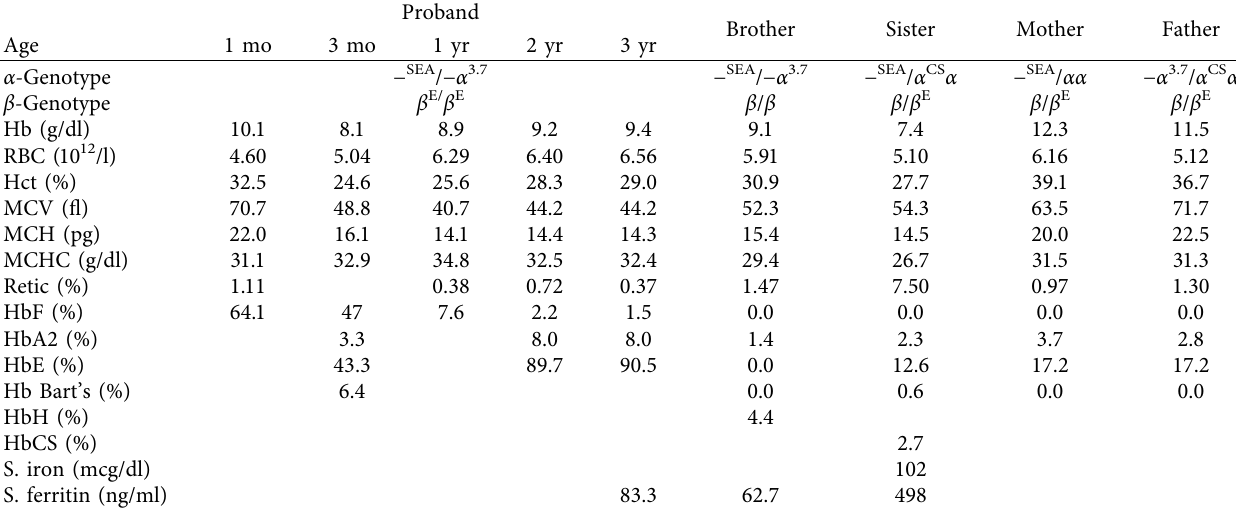
Table 1: Steady-state hematological indices of index case and family